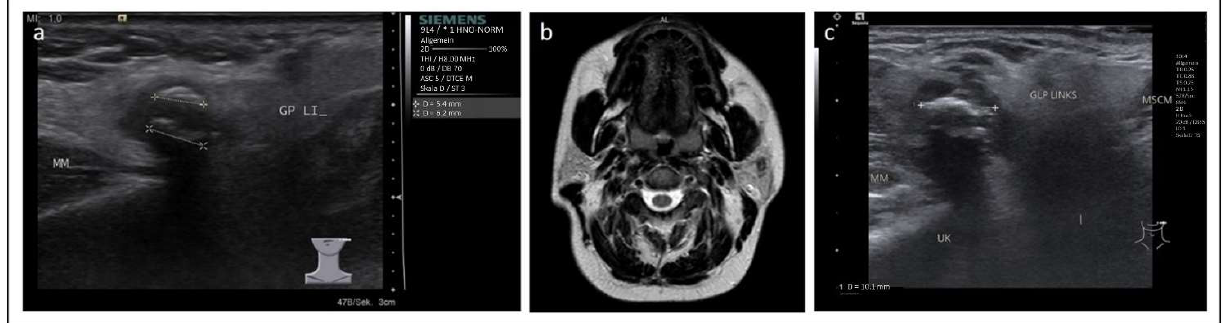
Figure 1. Ultrasound and MRI findings of a 37-year-old male patient with recurrent swelling and pain of the left parotid gland. ( a ) Initial ultrasonography examination revealing two echogenic reflexes (see markings) with dorsal sound cancelling in the anterior part of the left parotid gland. The remaining gland parenchyma shows hypoechoic changes, consistent with chronic sialadenitis. MM = masseter muscle, GP LI = left parotid gland. (Siemens Medical Solutions, Acuson S3000). ( b ) Initial MRI examination of T2 TSE transversal sequence showing unspecific inflammatory changes. ( c ) Pre-operative ultrasonography examination revealing the echogenic reflexes (see marking) with dorsal sound cancelling in the anterior part of the left parotid gland – but larger in comparison. MM = masseter muscle, GLP links = left parotid gland, UK = mandibule, MSCM = sternocleidomastoideus muscle. (Siemens Healthineers, Acuson Sequoia).